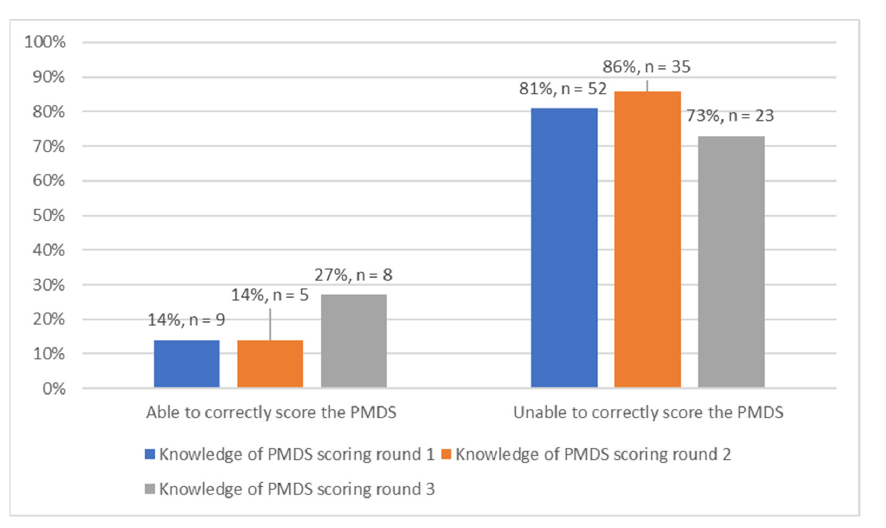
Figure 2. Knowledge of PMDS scoring ( n = 135).